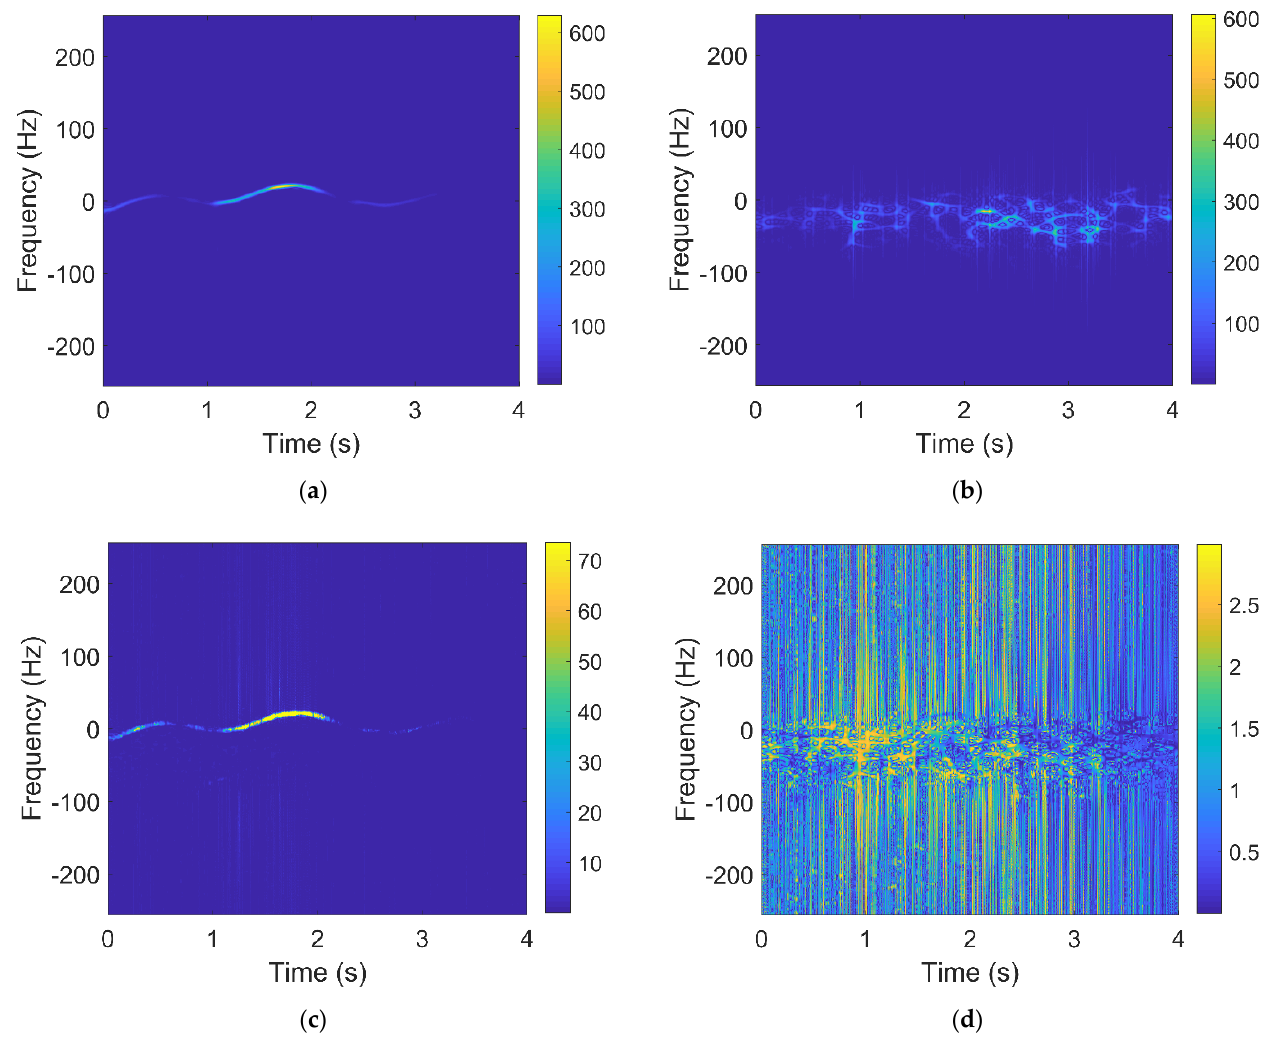
Figure 8. Time–frequency character figures of target echo and sea clutter. ( a ) Choi–Williams distribution (CWD) of target echo; ( b ) CWD of sea clutter; ( c ) N-CWD(Normalized–CWD) of target echo; ( d ) N–CWD of sea clutter.